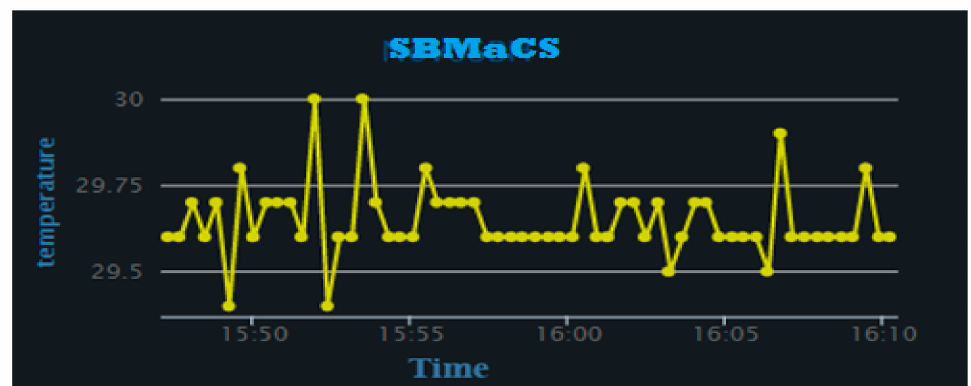
Figure 17. Temperature vs. time.